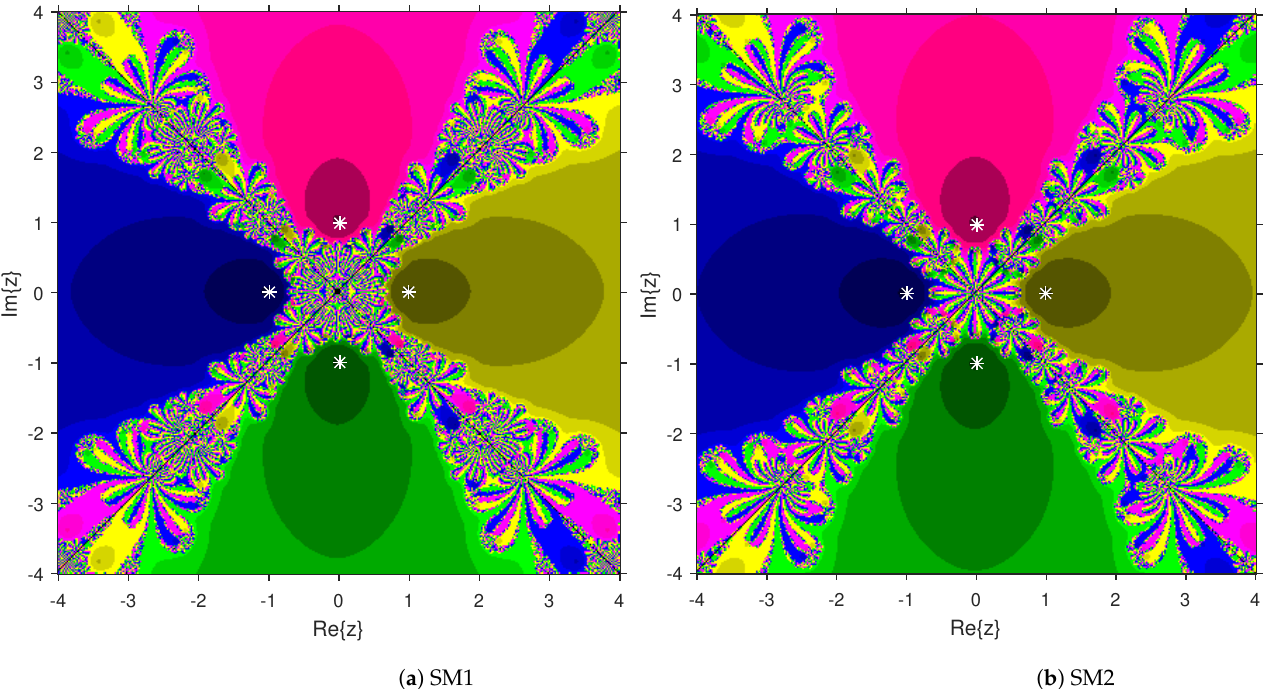
Figure 5. Attraction basins comparison between SM1 and SM2 related to M 5 ( z ) .